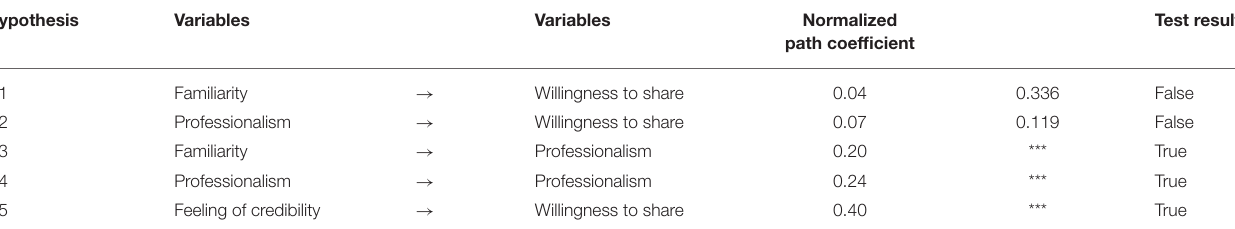
TABLE 5 | Research 1: model path coefficients and verification results. Hypothesis